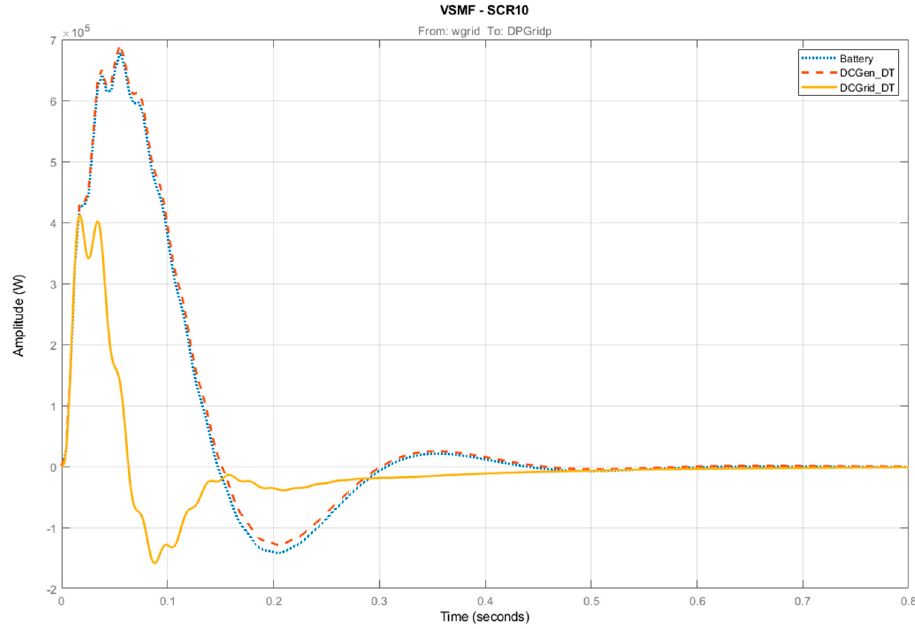
Figure 16. Step response comparing the DC link voltage control location frequency responses.